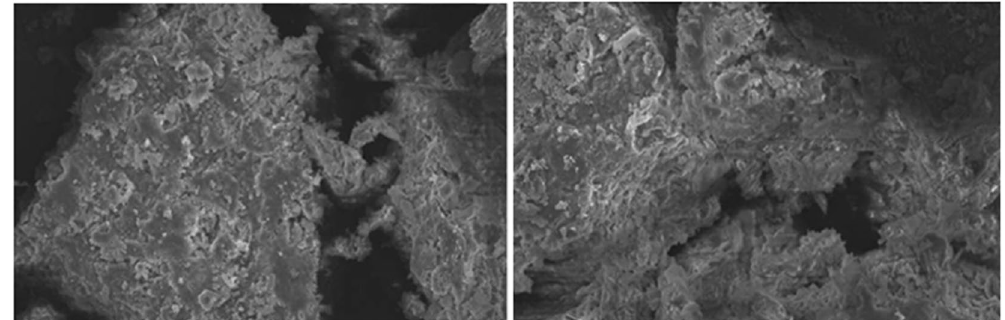
Figure 3. Morphology change of flocs before (left) and after (right) flocculation by EPS.